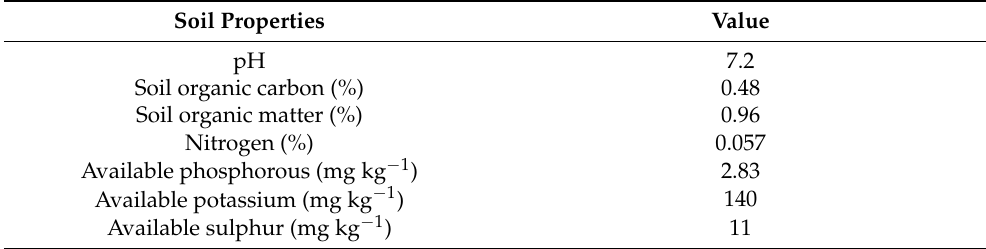
Table 1. Chemical properties of soil (initial) used for the